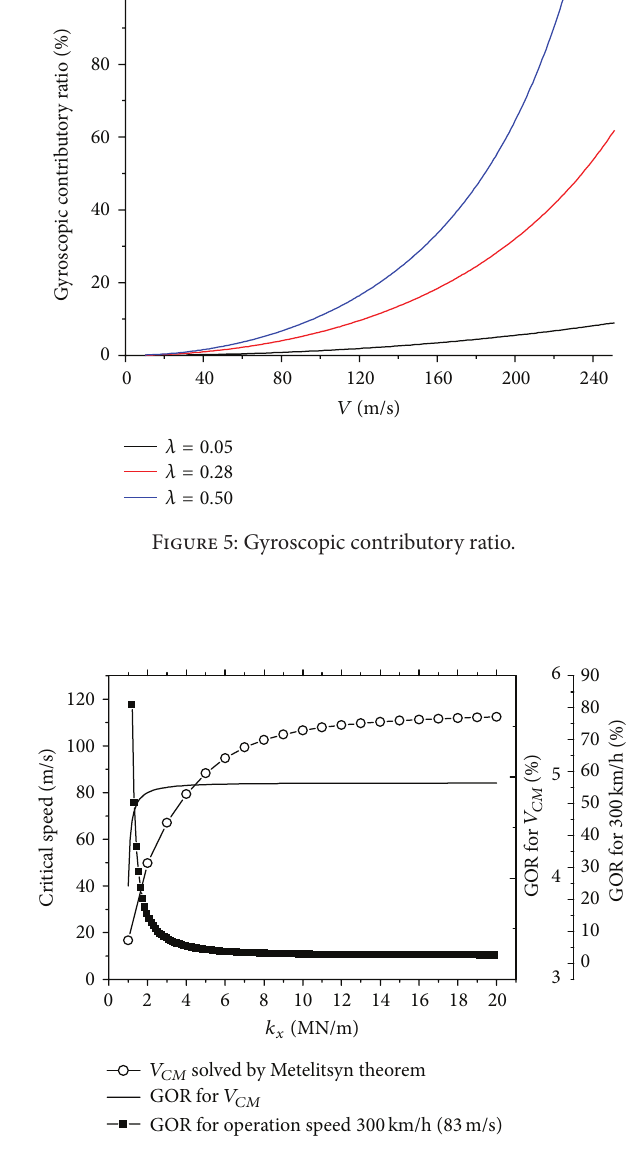
Figure 6: Influence of 𝑘 𝑥 on 𝑉 𝐶𝑀 and